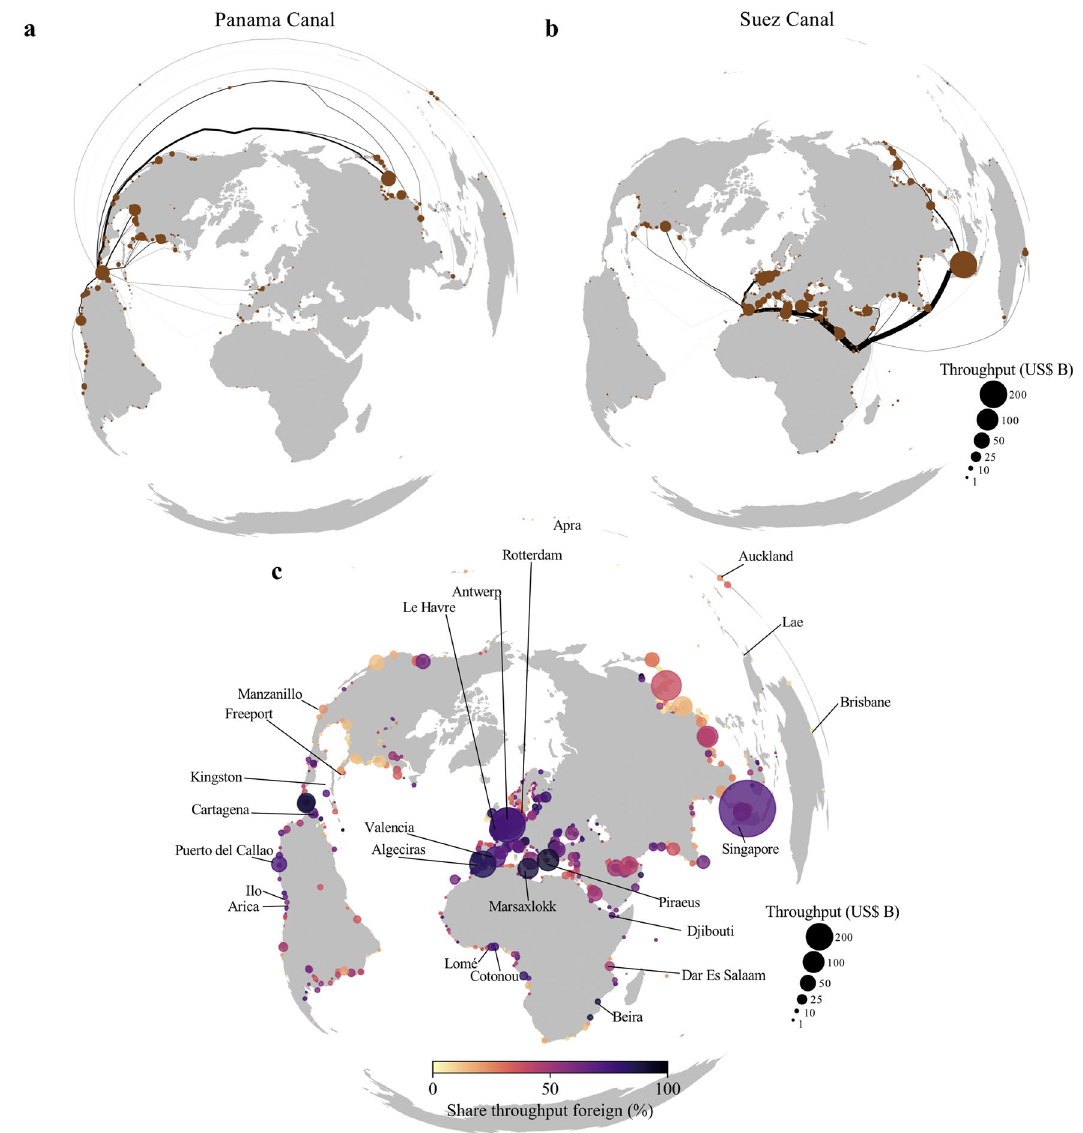
Fig. 3 | The origin and destination portsoftrade fl ows. The aggregated imports ( a )andexports( b )perport.Thecriticalportsarehighlightedwiththetop10ports